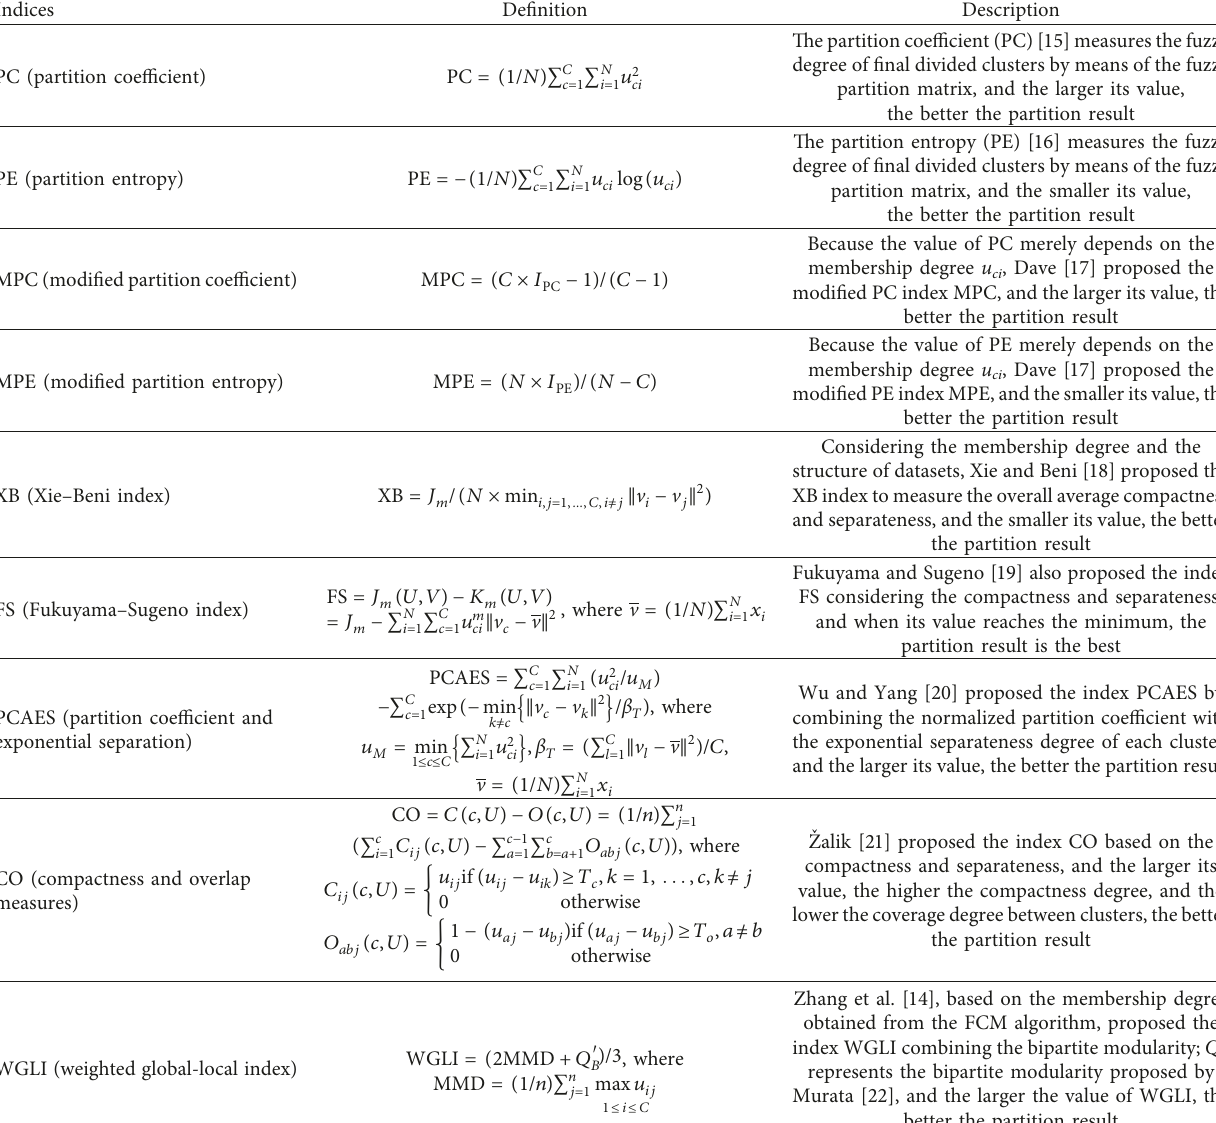
Table 1: The commonly used fuzzy clustering validity